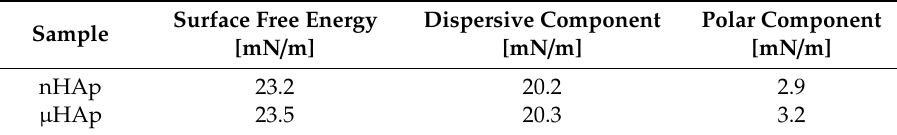
Table 1. The values of surface free energy, as well as its polar and dispersion components calculated for nano- and microHAp powders.